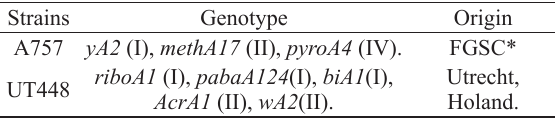
Genotype and origin of A. nidulans strains.